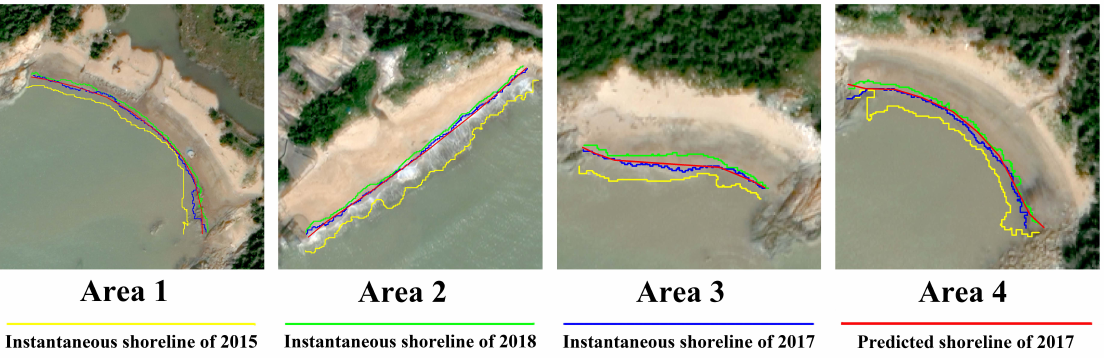
Figure 13. Tidal correction of four typical experimental areas.